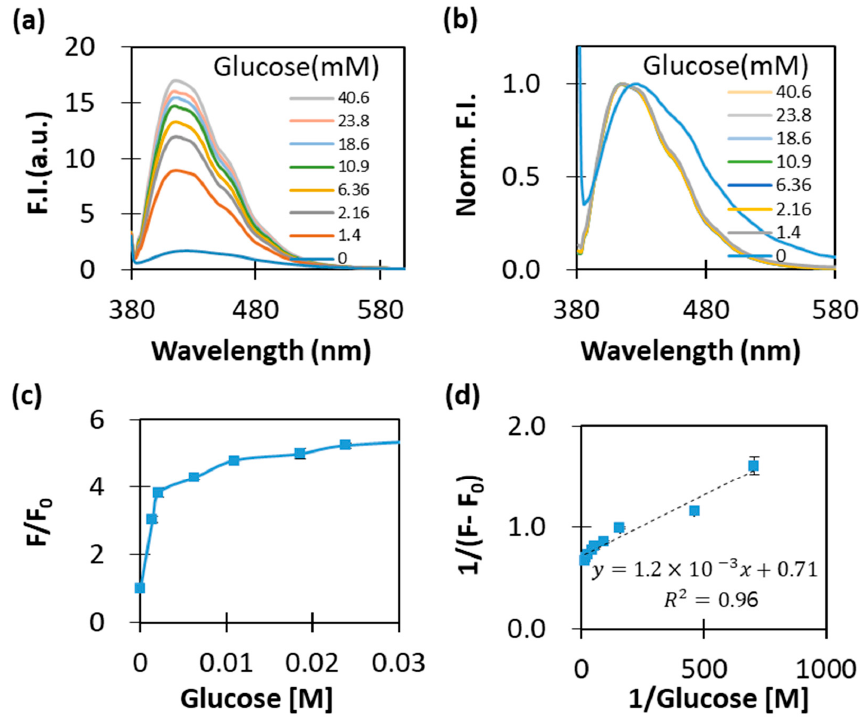
Figure 5. Glucose-binding properties of TDA. ( a ) Emission spectra. ( b ) Normalized emission spectra. Fluorescence intensity at the maximum wavelength was used for the normalization. ( c ) Relative fluorescence intensity. ( d ) Benesi–Hildebrand plot.